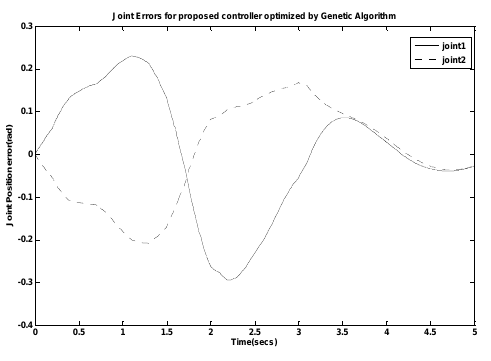
Fig. 10. Error profiles for the two joints using GAFPPDC.